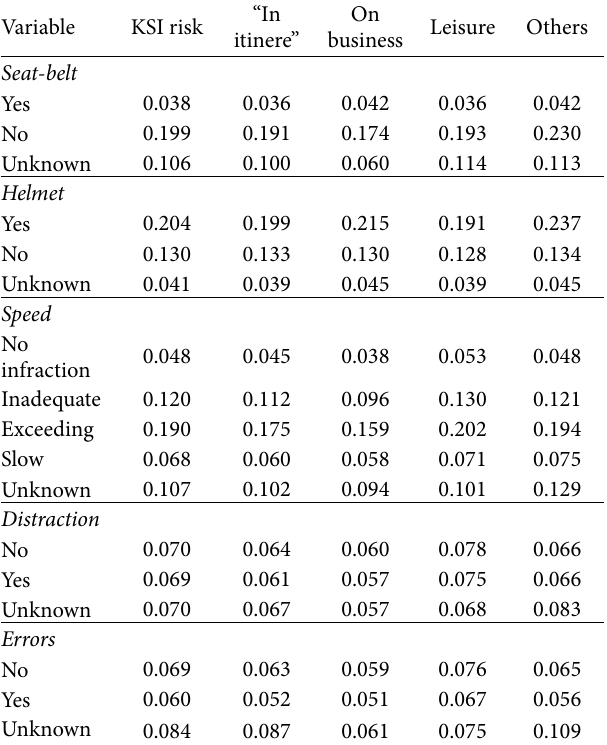
Table 4: Probabilities of suffering a serious accident, depending on the type of displacement and distraction or errors made by the driv- ers. Processed by the authors.